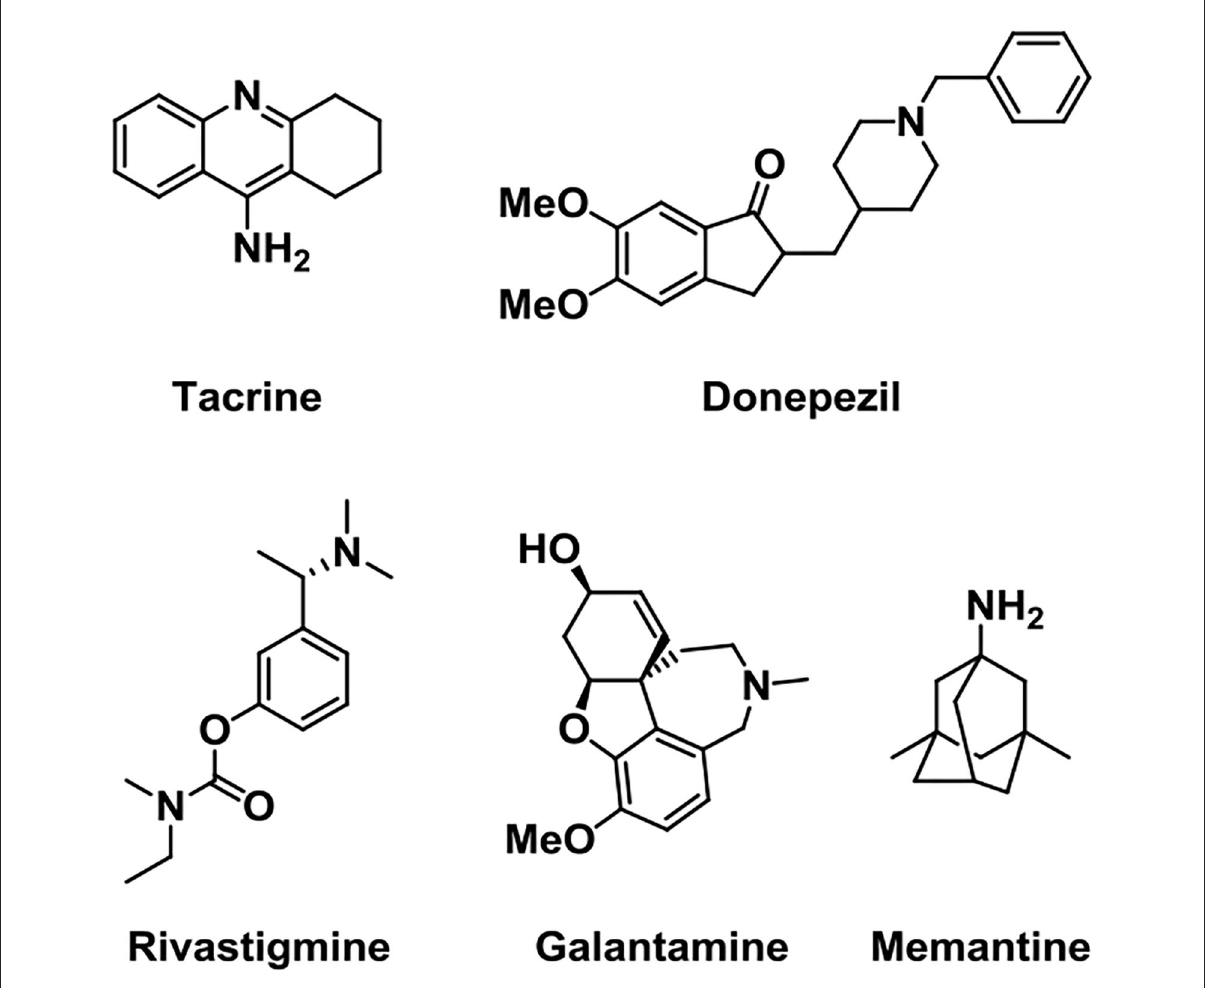
(Figure 4), slowing down the progression of AD by inhibiting A β formation at an early stage. Therefore, the therapeutic potential of BACE1 inhibitors is currently tested in the clinical trials for AD treatment (Piton et al.,